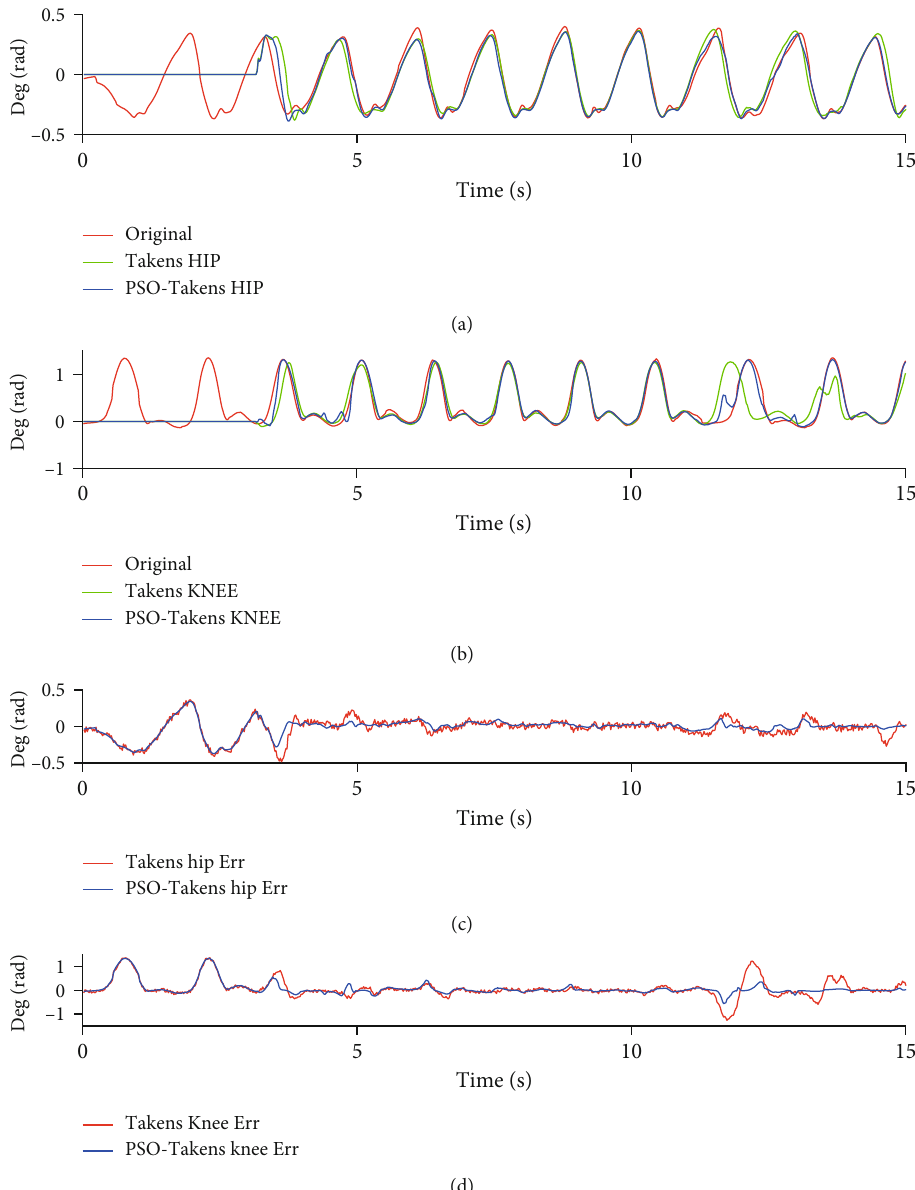
Figure 10: System joint angular output (a). System hip joint angle output (b). System knee joint angle output (c). Hip joint follow control angle error (d). Knee joint follows control angle